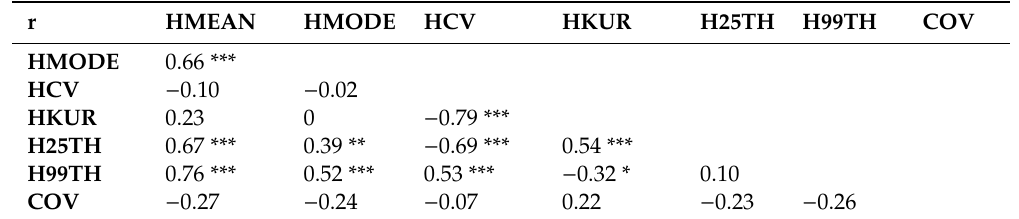
Table 4. Pearson correlations among selected LiDAR metrics.